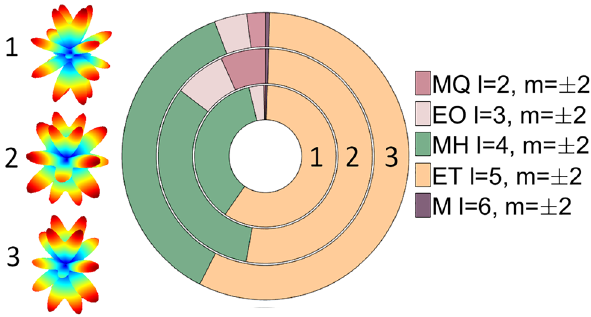
Figure 7: Comparison of the far-field diagrams and multipolar compositions of the SHG electromagnetic field and the disk's eigenmodeat the SHfrequencyfor parametersof the maximumSHG efficiency ( λ 0 =1600 nm, r =470 nm, h =645 nm): 1 - SH mode, 2 - AP beam excitation, 3 - PW excitation. E/M – electric/magnetic multipoles, Q – quadrupole, O – octupole, H –